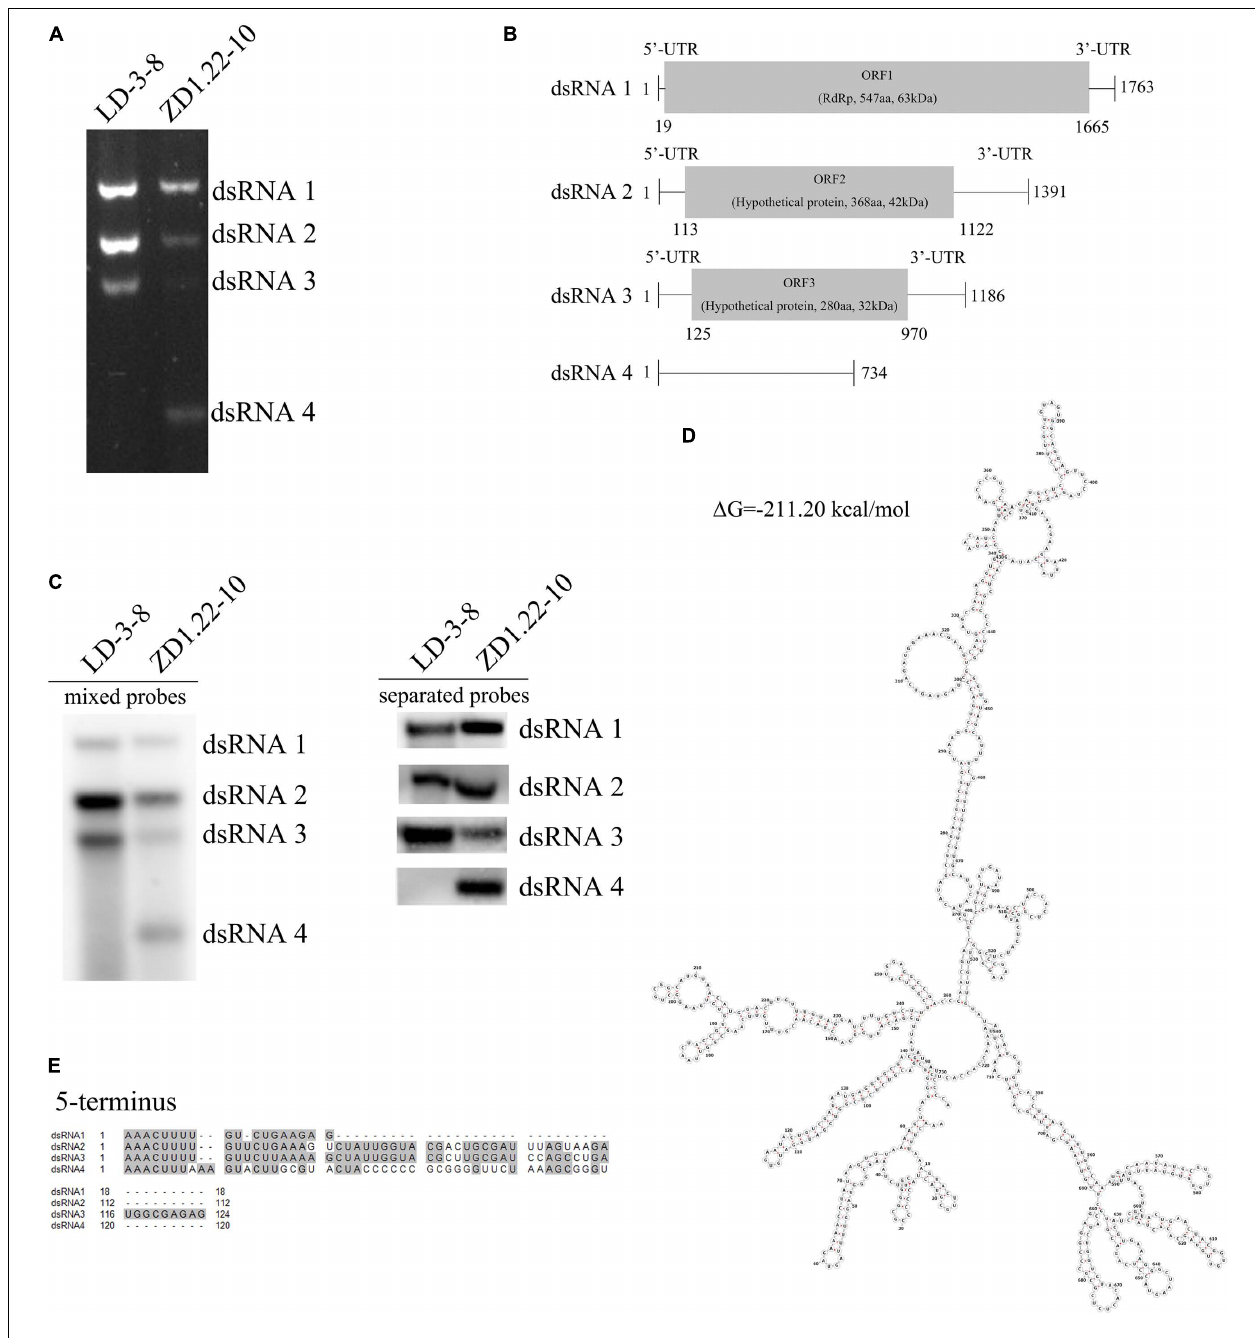
FIGURE 1 | Genomic organization of AfPV1 and SatRNA. (A) Agarose gel electrophoresis of the dsRNA segments extracted from A. flavus isolate LD-3-8 and ZD1.22-10. (B) Genome organization of dsRNA1, dsRNA2, and dsRNA3 indicated by the diagrammatic representation. (C) Detection of dsRNA1, dsRNA2, dsRNA3, and dsRNA4 by northern blot. Probe-dsRNA1, probe-dsRNA2, probe-dsRNA3, and probe-dsRNA4 were mixed or used separately to detect RNAs. (D) Secondary structure analysis of the dsRNA4 using RNAstructure 6.3 (Lu et al., 2006) showed that ribonucleotides are involved in the formation of secondary structures and predicted the presence of stem-loop structures. (E) Identity at the 5 (cid:48) -terminal of dsRNA1, dsRNA2, dsRNA3, and dsRNA4. Gray shading indicates that nucleotides are identical in the three segments.